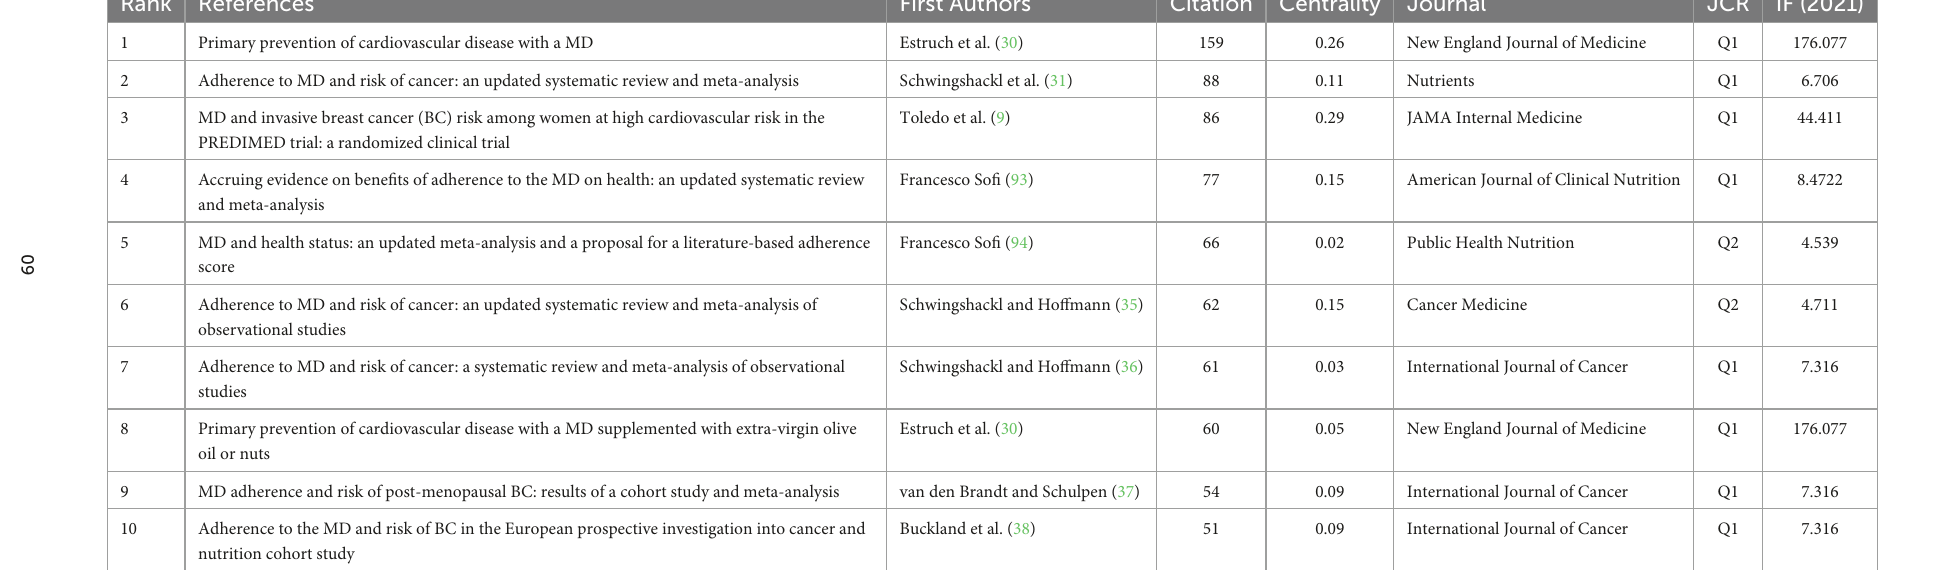
TABLE 4 Top 10 high-cited references related to the Mediterranean diet (MD) on